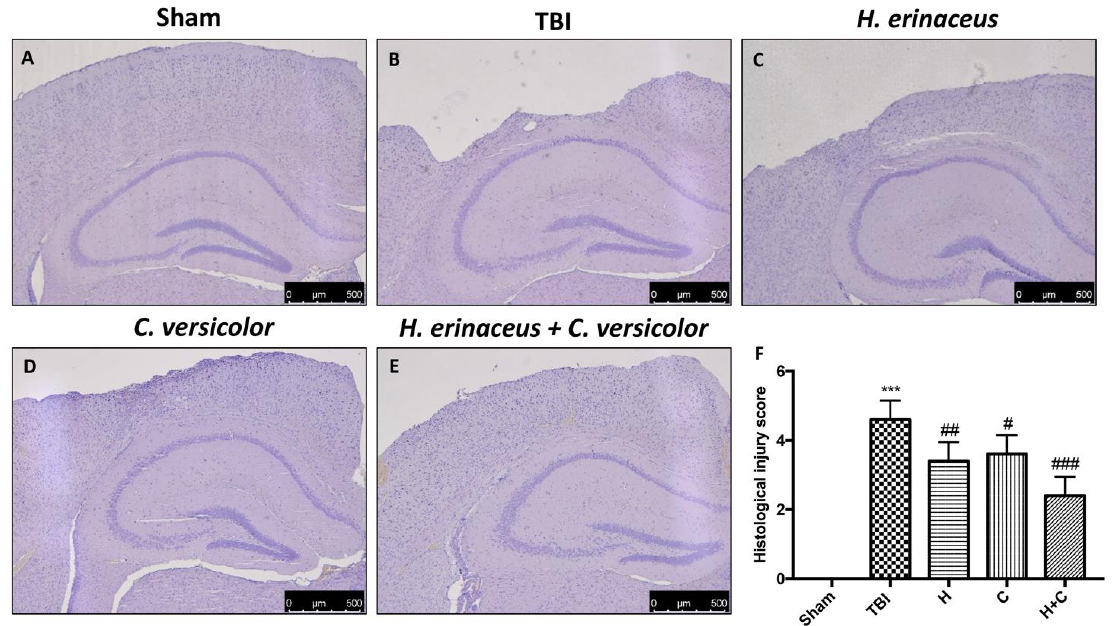
Figure 1. H. erinaceus (H), C. versicolor (C) and H. erinaceus + C. versicolor (H + C) reduce the severity of brain trauma . No alterations in brain tissues from Sham mice ( A ). In contrast, brain images after traumatic brain injury (TBI) show tissue disorganization and white matter alteration at 30 days post injury ( B ). Significant protection from TBI was evident in tissue collected from mice treated with H ( C ), C ( D ) and especially H + C ( E ). The figures are representative of at least three experiments performed on different experimental days. Each data is expressed as the mean ± standard error of the mean (SEM) of n = 5 male CD1 mice for each group. ( F ) *** p < 0.001 vs. Sham; ## p < 0.01 vs. TBI; # p < 0.05 vs. TBI; ### p < 0.001 vs. TBI.